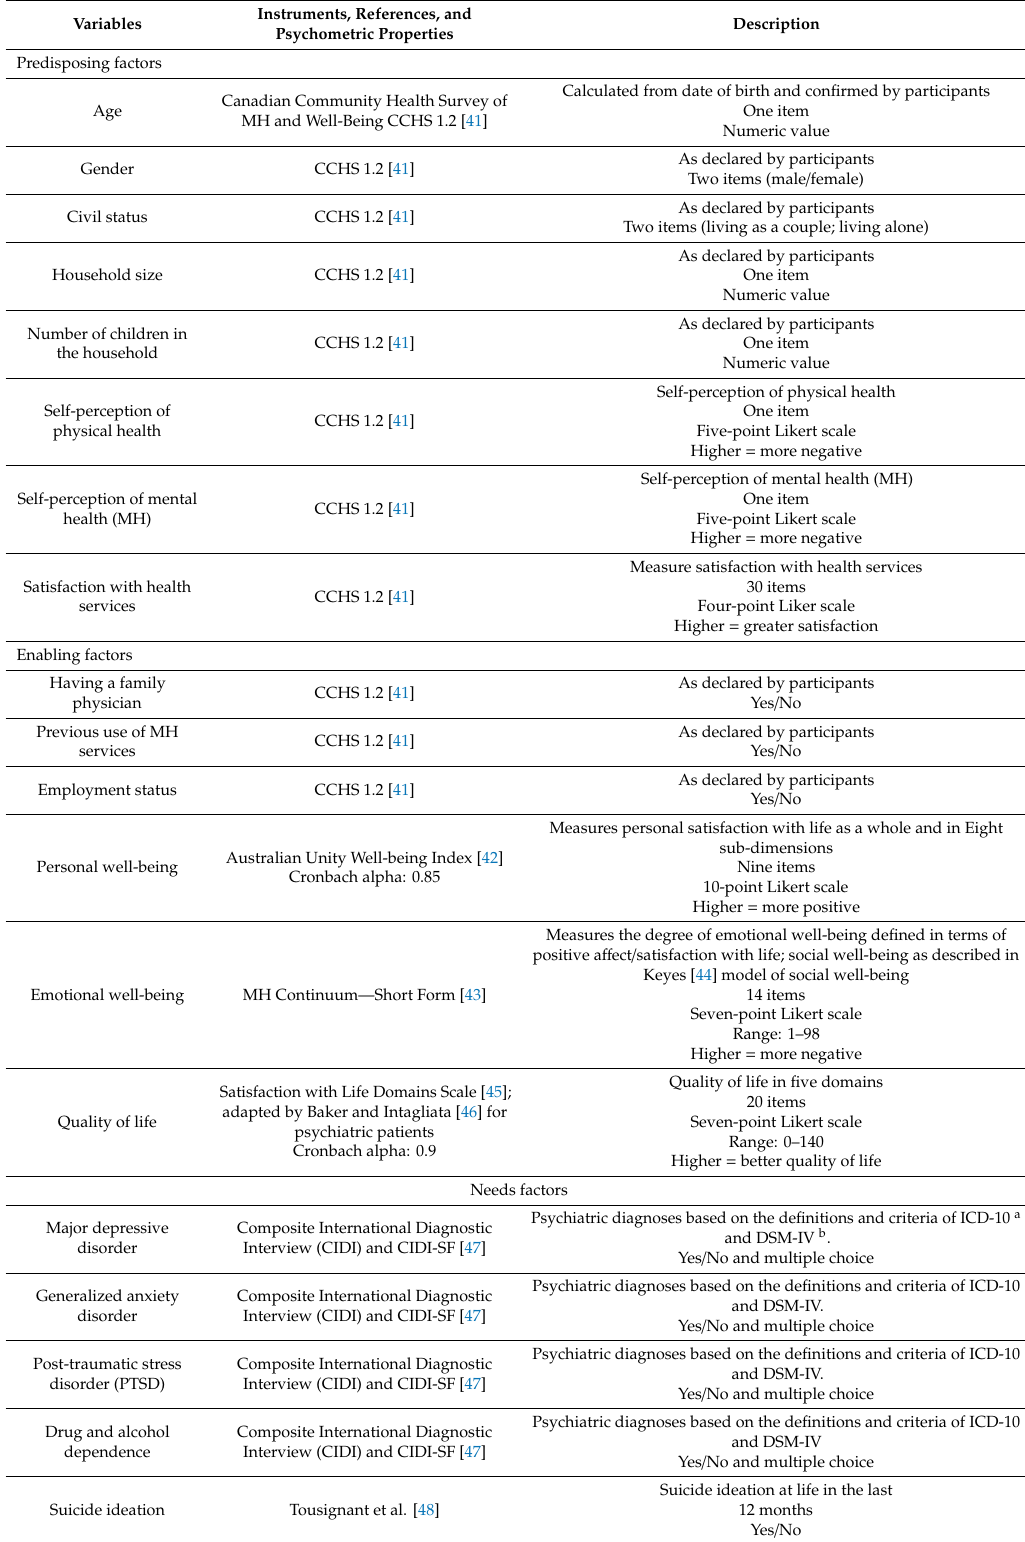
Table 1. Measurement